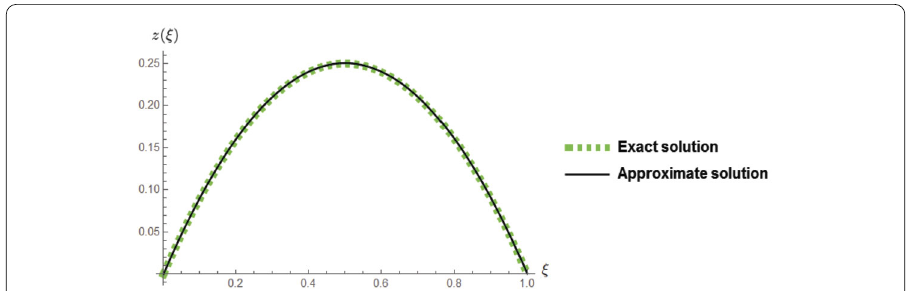
Figure 1 Exact and MRKHS solution curves of Example 5.1